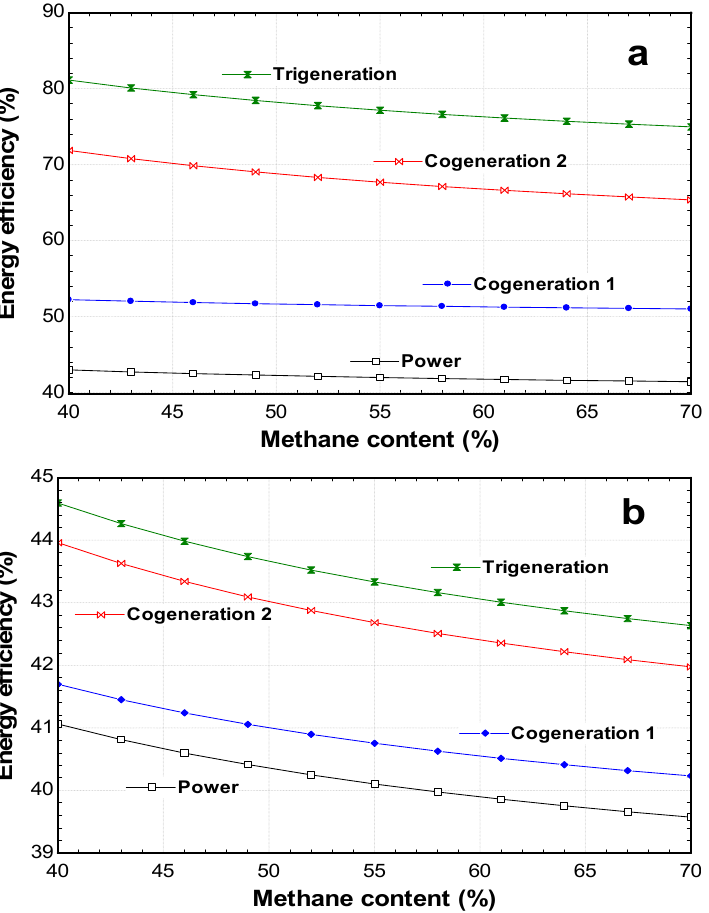
Figure 6. Effect of the biogas methane content on the ( a ) energy and ( b ) exergy performance of the sub-systems and the multigeneration system.